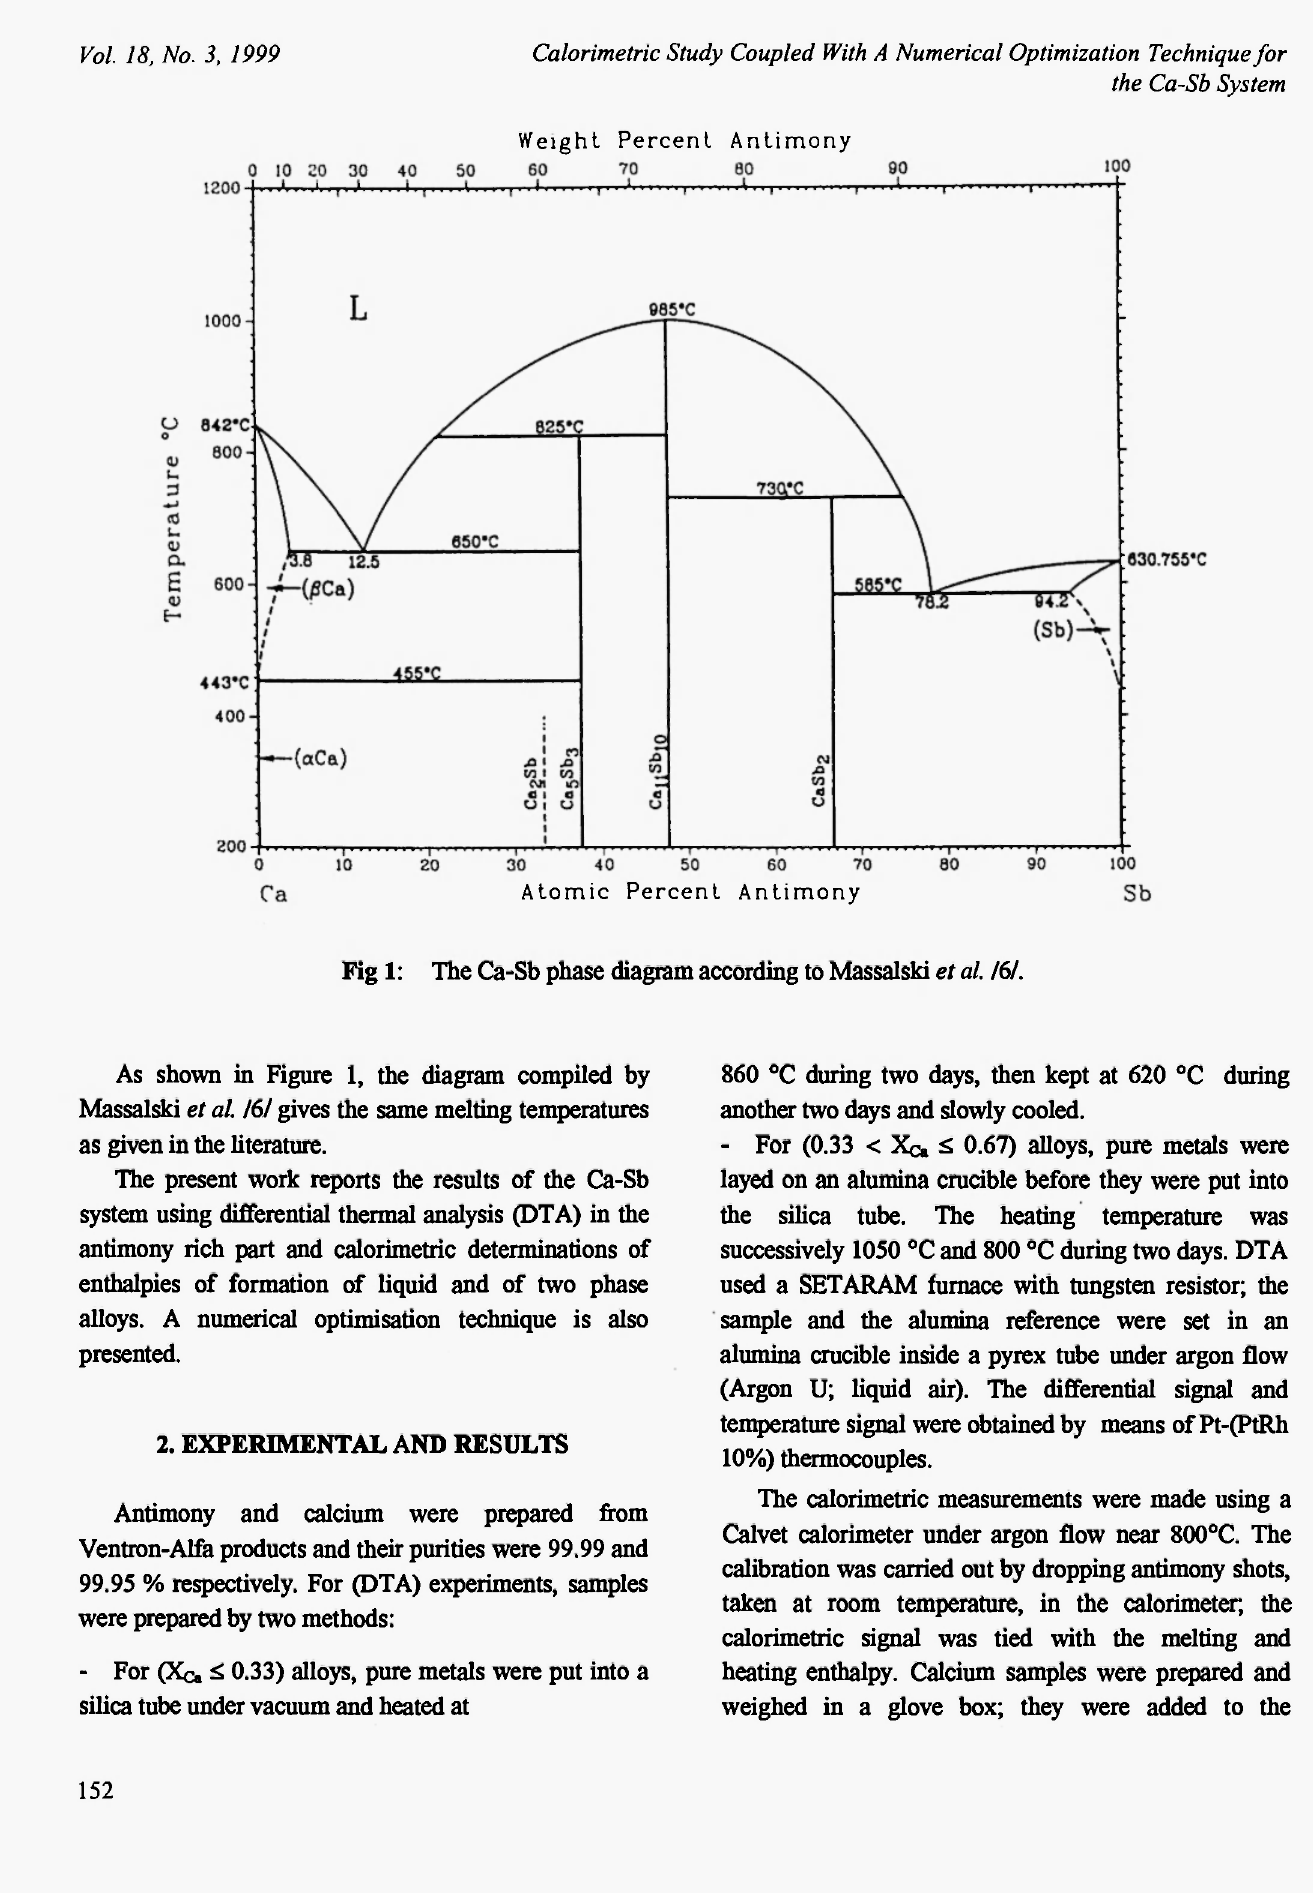
Fig 1: The Ca-Sb phase diagram according to Massalski et al.